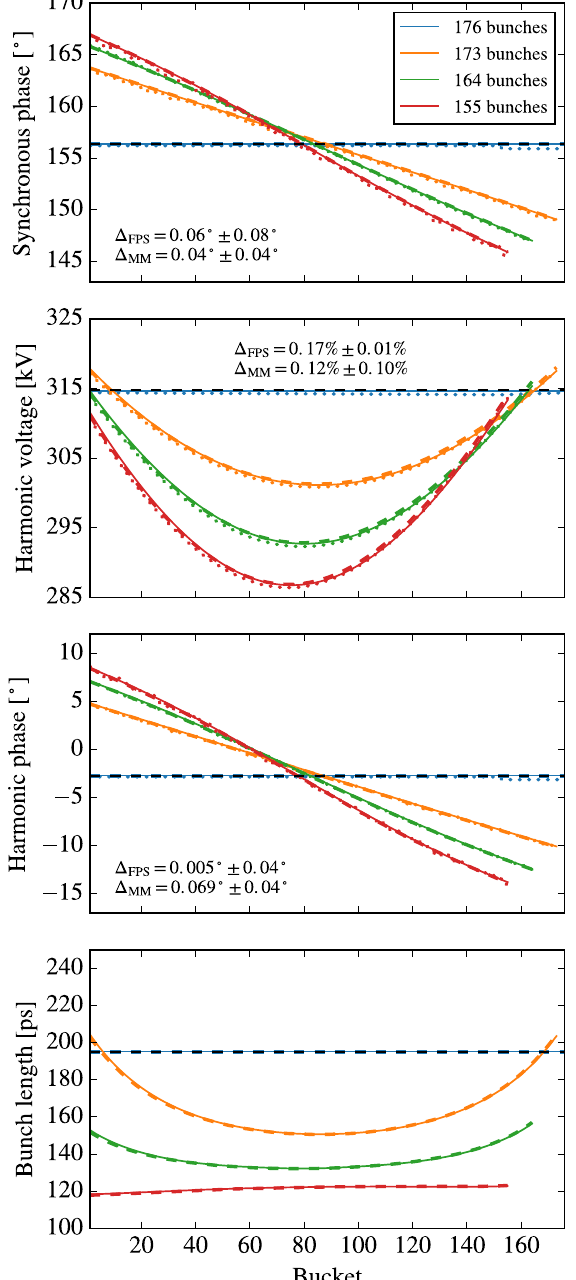
FIG. 4. Synchronous phase, harmonic field and bunch length for different gaps when the form factor has been set to 1 for the matrix formulation (solid) and F ILL P ATTERN S IM (dashed). The MBTRACK results (dotted) and the analytical values for a uniform fill pattern (black dashed) are shown for comparison. The mean and RMS of the deviations from the MBTRACK results are displayed for the case with 164 bunches. Note that no bunch lengths are obtained from MBTRACK when only having one particle in the